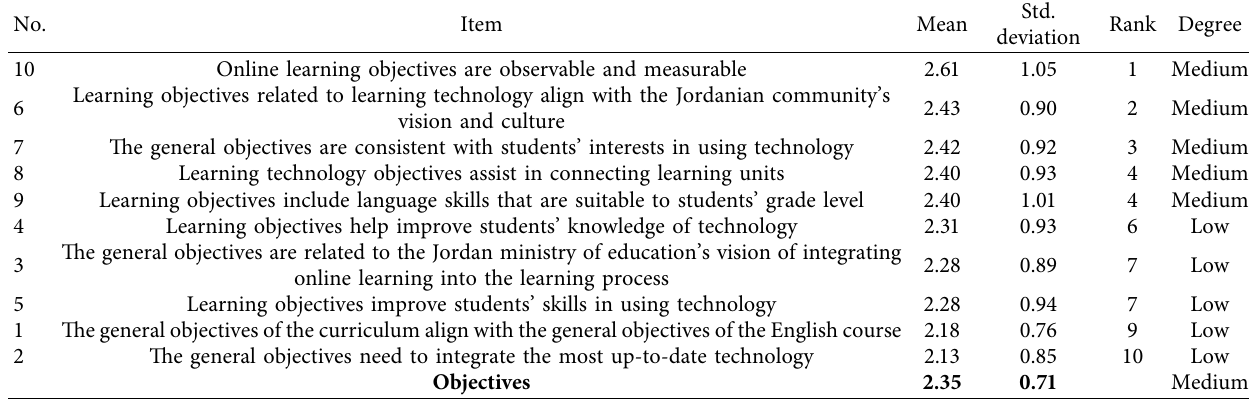
Table 7: Standard deviations, means, ranks, and degree of the study sample on the field of objectives. No. Item Mean